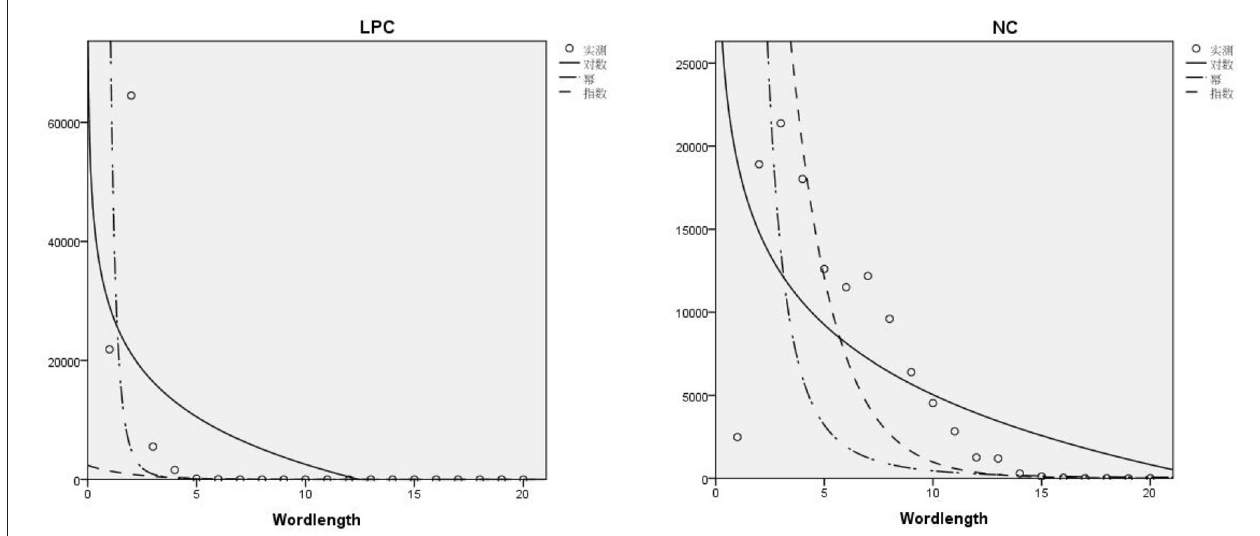
FIGURE 2 | Dispersion diagram of word length and frequency of LPC and NC.